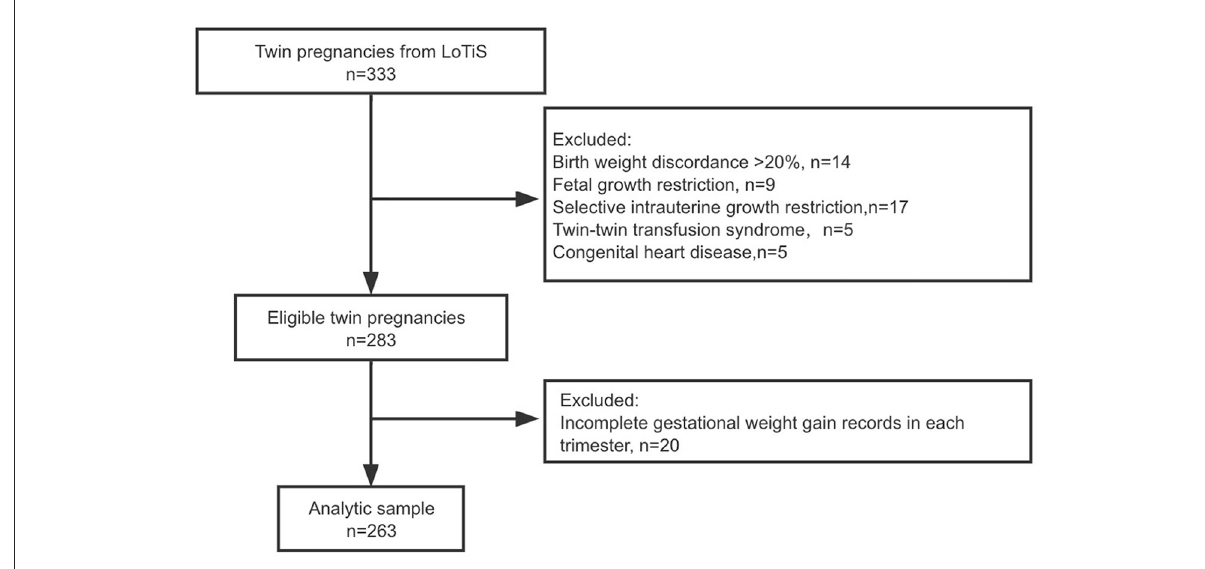
FIGURE1 Flowchart showing the selection of twin pairs included in the final analysis of child growth trajectories.